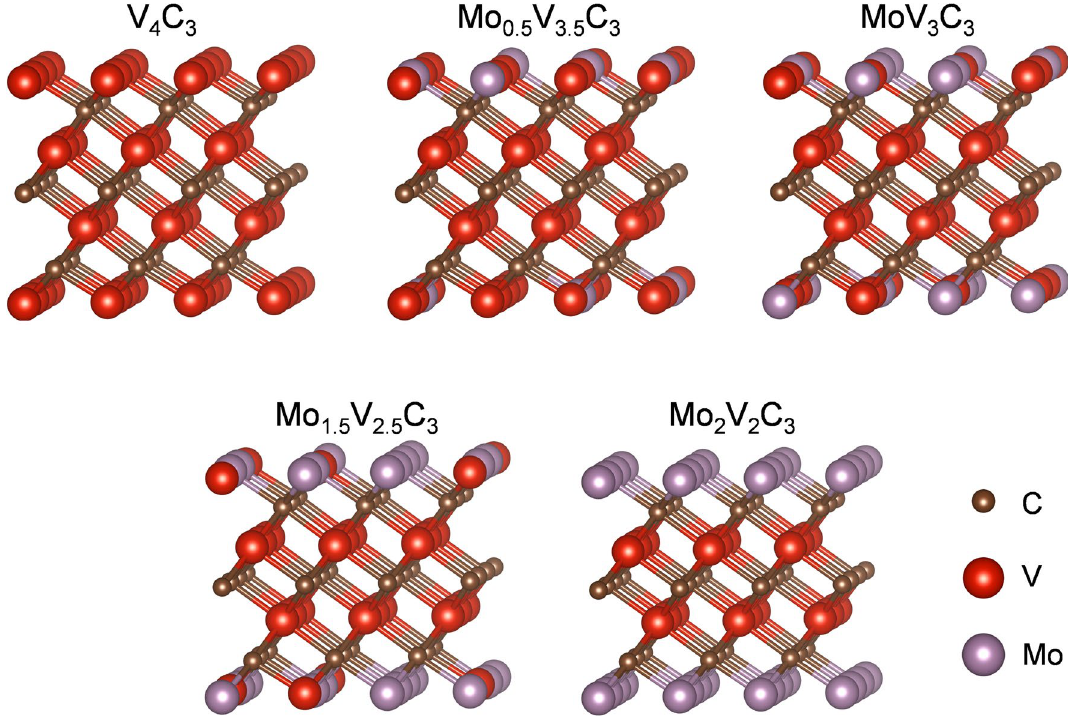
Figure 6. Atomic models of the stable MXenes according to Fig.